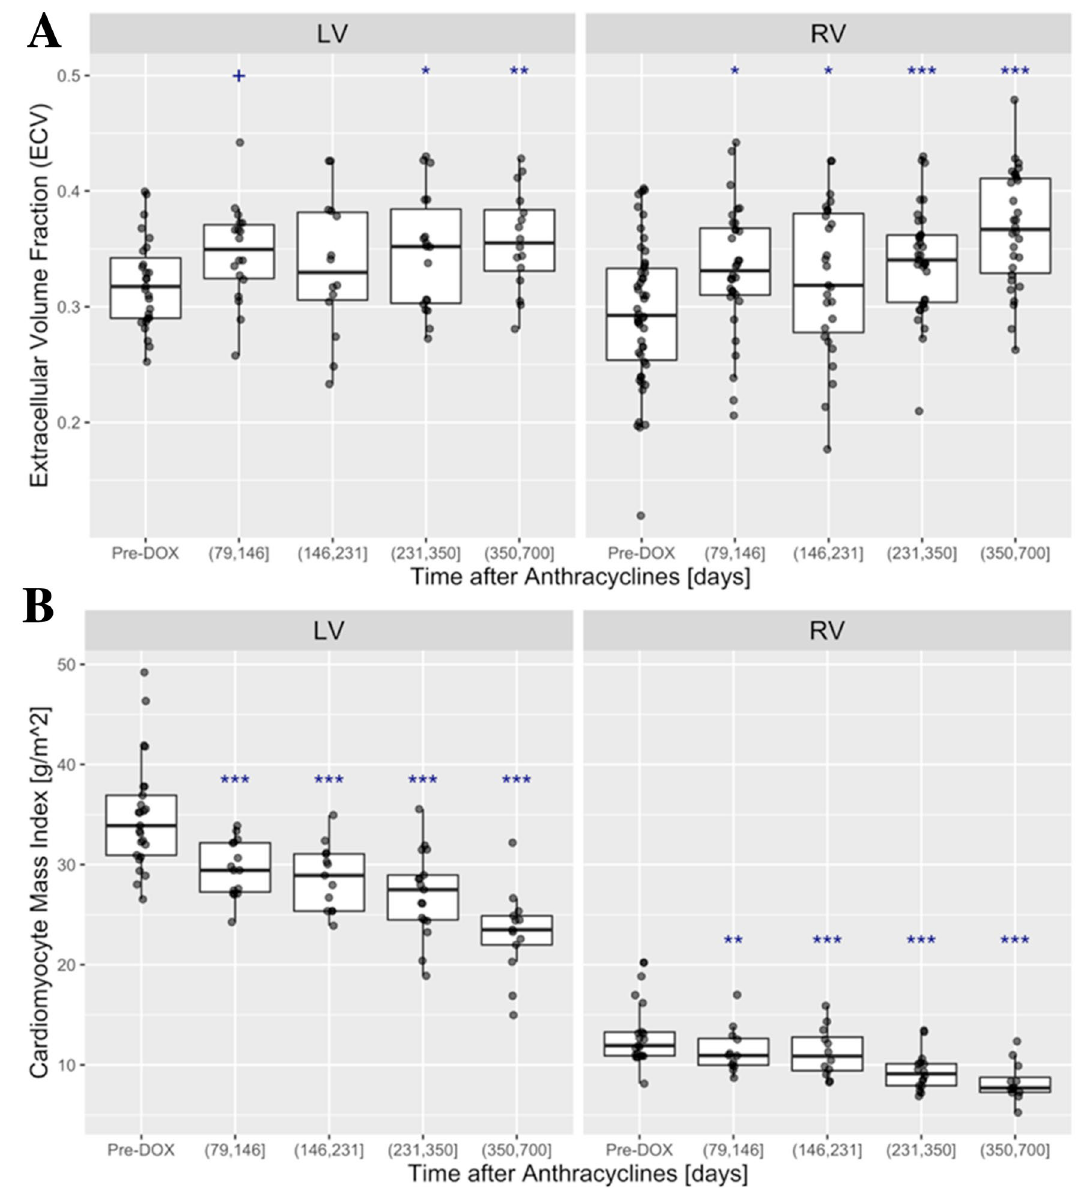
Figure 2. Baseline and post-anthracycline LV and RV of the ECV and cardiomyocyte mass index (CM): ( A ) LV ECV (left) increased from 0.32 ± 0.04 at baseline, by 0.037 (11%), to 0.36 ± 0.04 in the (350, 700] day period ( P = 0.0035 for (350, 700] days vs. baseline). The RV ECV (right) also increased from the baseline value of 0.26 ± 0.07 by 0.14 (53%) to 0.40 ± 0.1 in the (350, 700] day period ( P < 0.001 for (350, 700] days vs. baseline). ( B ) LV and RV cardiomyocyte mass decreased steadily after anthracyclines ( + P < 0.1; * P < 0.05; ** P < 0.01; *** P <